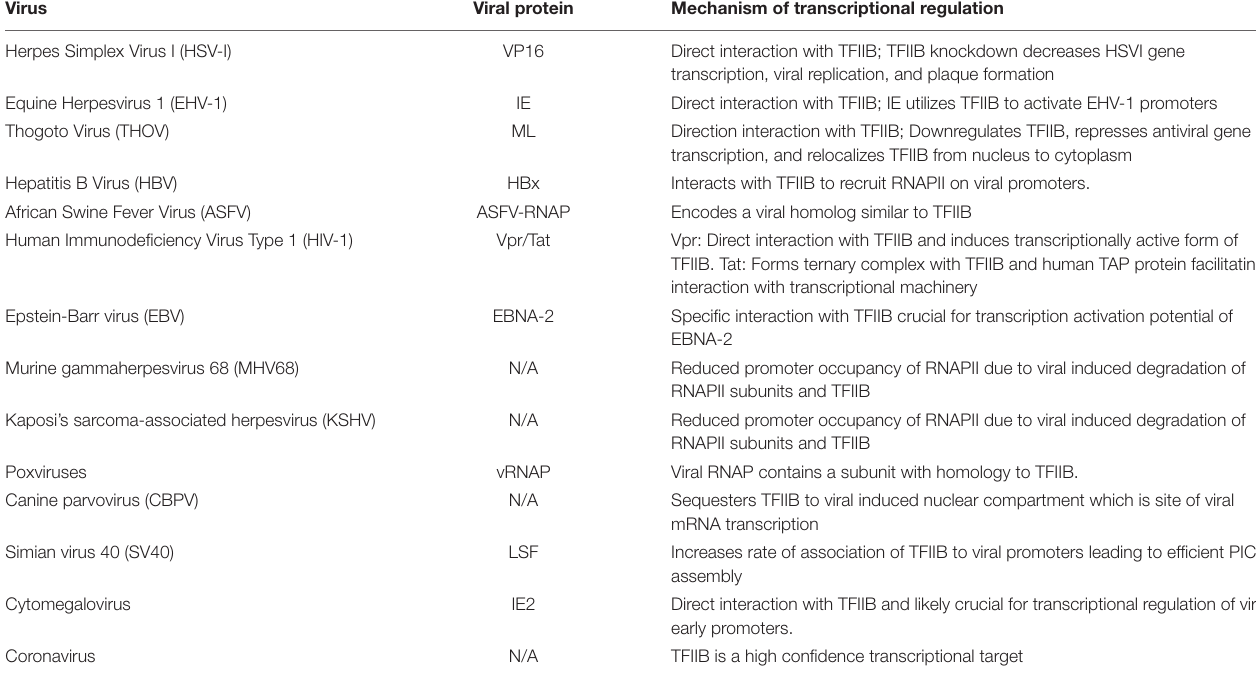
TABLE 1 | Viruses, their respective viral proteins, and the mechanism by which they regulate transcription. Virus Viral protein Mechanism of transcriptional